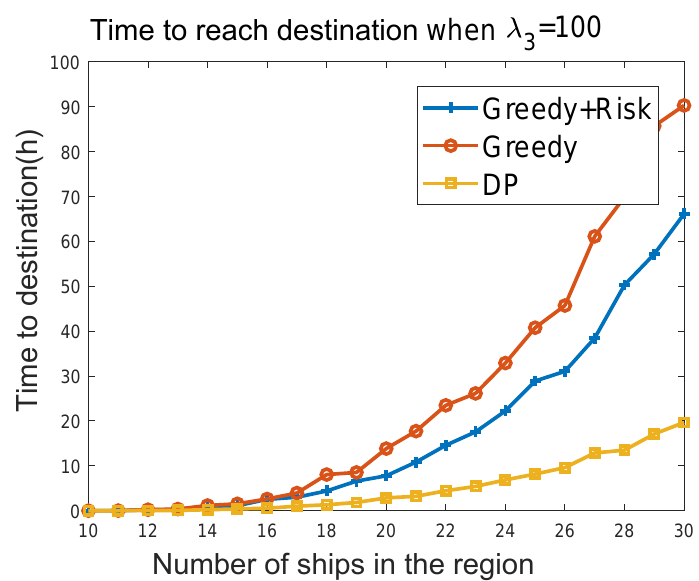
Figure 13. Time to destination vs. density of ships when λ 3 =